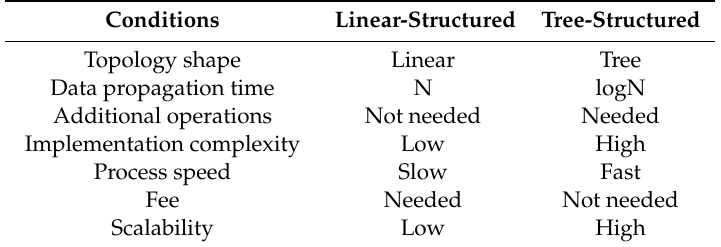
Table 1. A comparison between a linear-structured blockchain [15,16,20] and a tree-structured